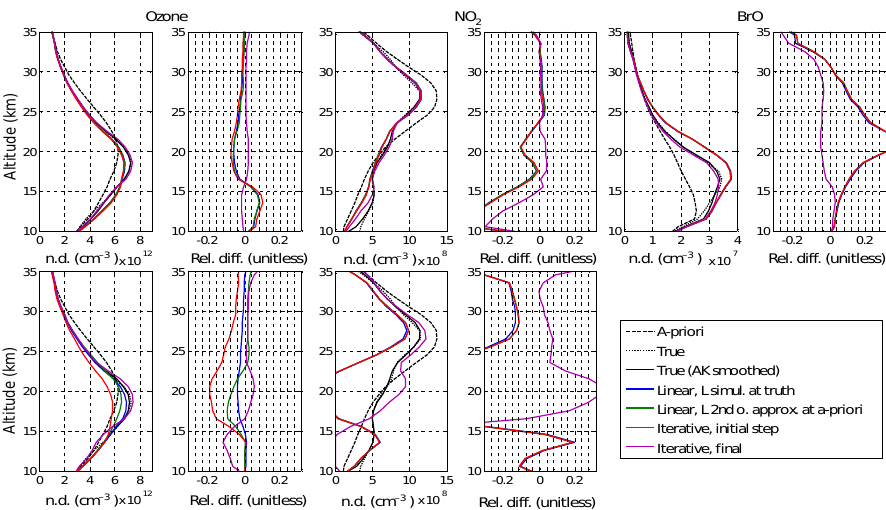
Figure 18. Same as Fig. 13 but for the application of standard DOAS. The final profile but without consideration of the cross-correlative terms between different absorbers (magenta dotted line in the original figure) is not shown